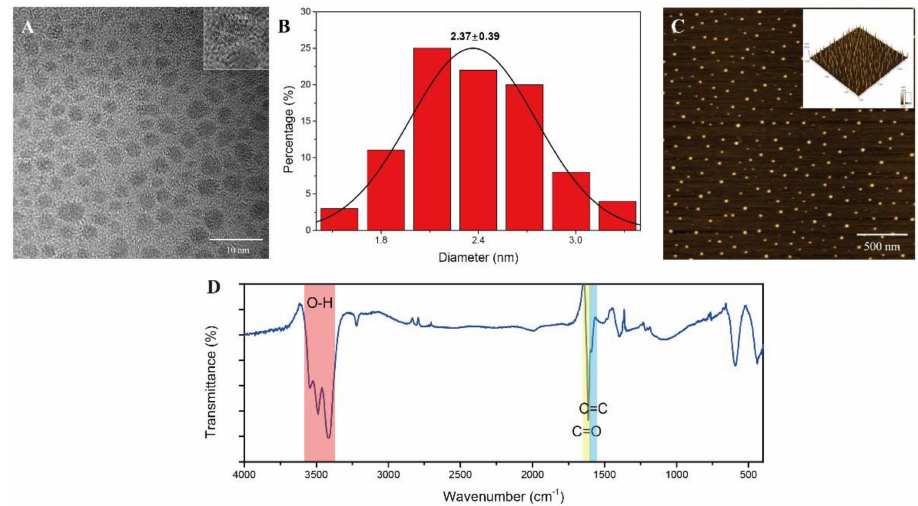
Figure 1. Morphological characterization of bCD. ( A ) TEM image of bCD (Inset: HRTEM image of bCD, and the lattice was 0.21 nm); ( B ) Histograms of the particle size distributions of bCD; ( C ) AFM image (Inset: size distribution of bCD); ( D ) FT − IR spectra of